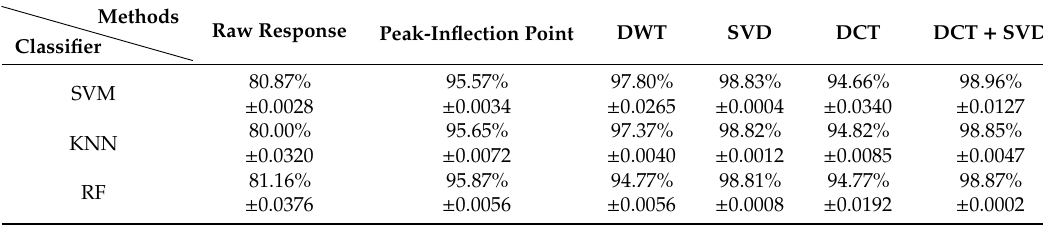
Table 3. Classification accuracy of other